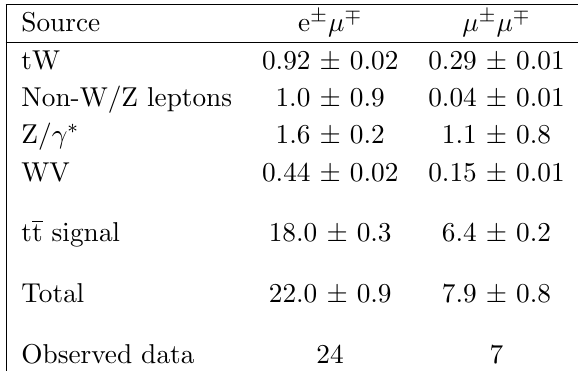
mea- tt =(cid:27) (in %), as well as absolute tt tt